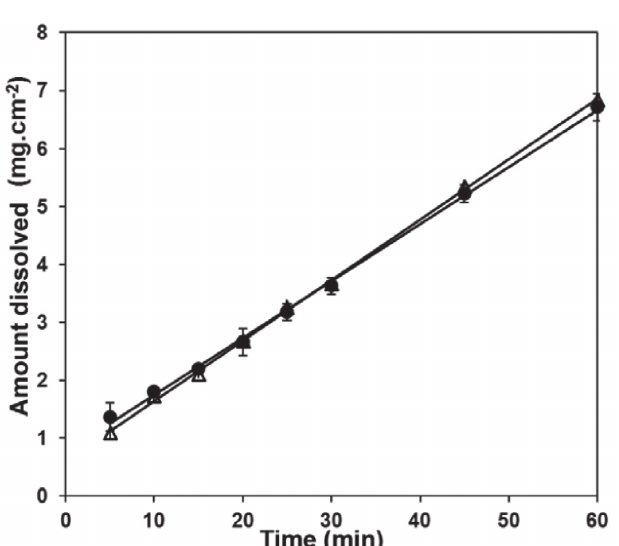
FIGURE 5 - Intrinsic dissolution of prednisone samples A and B in 900 mL of water containing 1.2% sodium lauryl sulfate using apparatus 2 at 150 rpm .